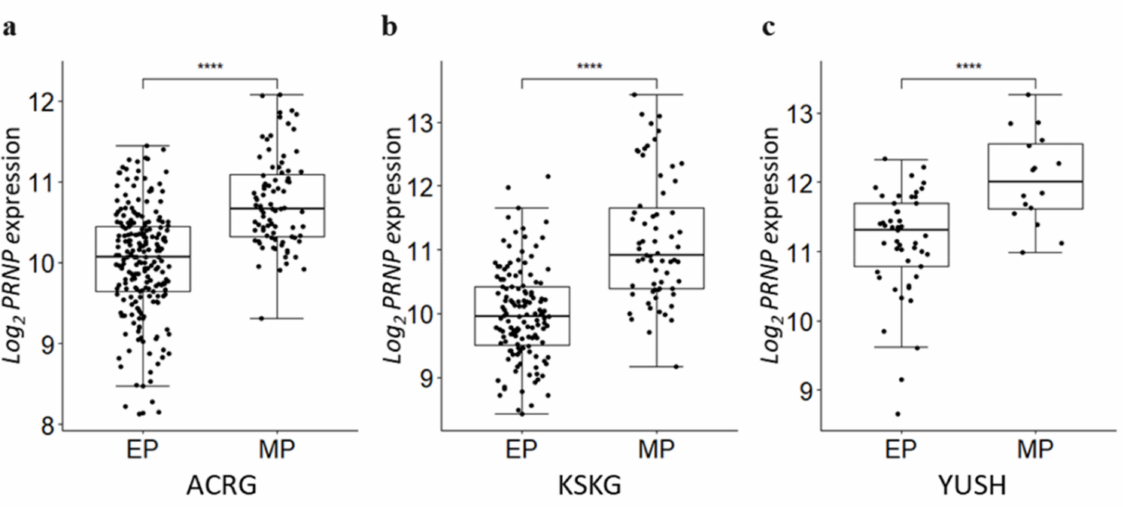
Figure 6. PRNP expression according to GC phenotype. ( a ) In the ACRG cohort, MP had significantly upregulated PRNP expression compared to EP. ( b ) In the KSKG cohort, MP had significantly upregu- lated PRNP expression compared to EP. ( c ) In the YUSH cohort, MP had significantly upregulated PRNP expression compared to EP. • , a patient; ****, p <